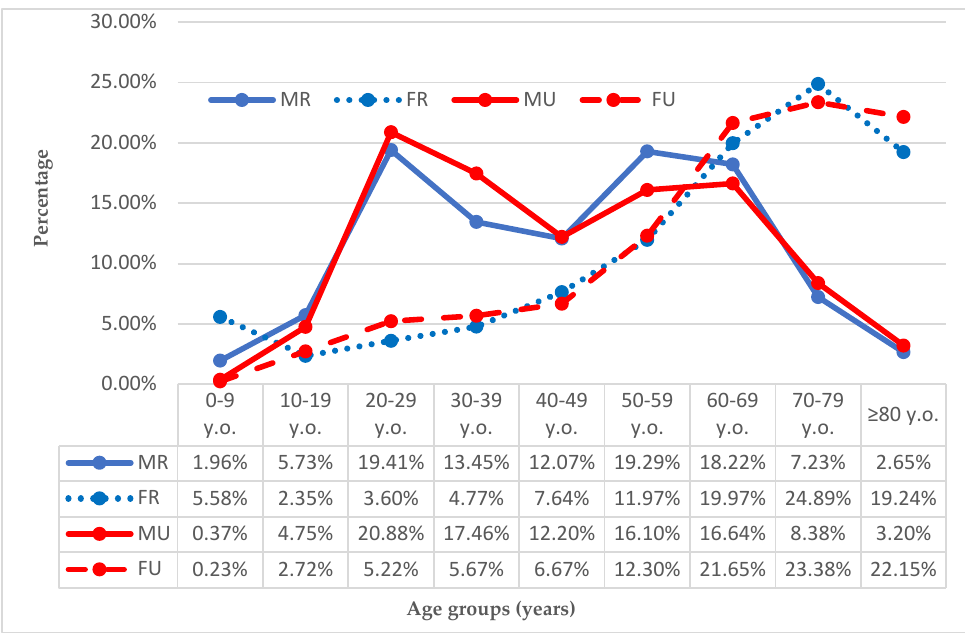
Figure 3. Prevalence (%) of dislocations by age and sex. Legend: FR, female rural population; FU, female urban population; MR, male rural population; MU, male urban population.